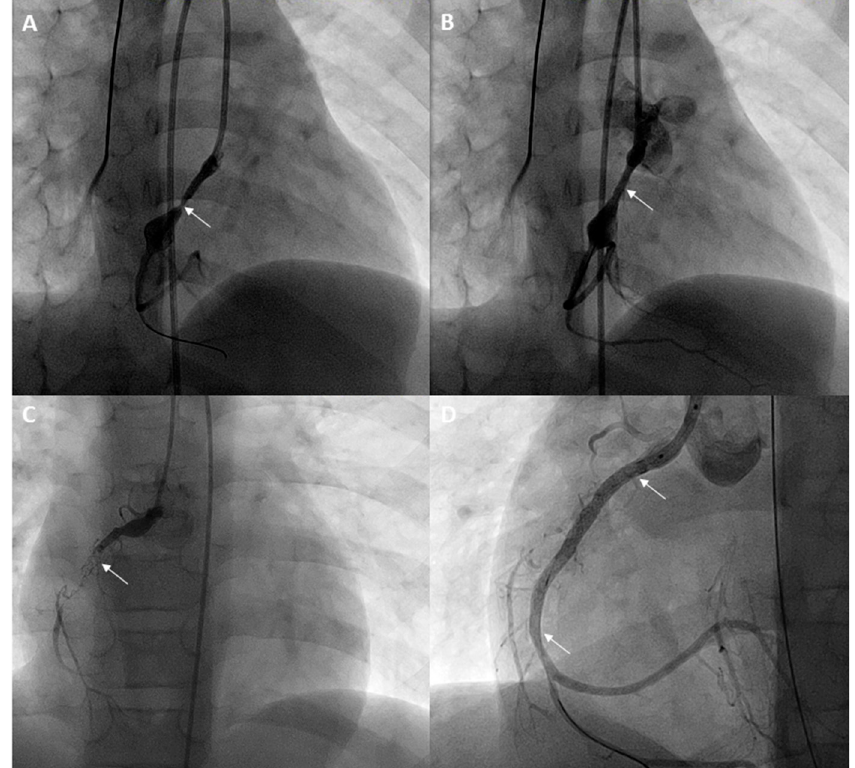
Figure 1. A 7-year-old with a history of Kawasaki disease and giant coronary artery aneurysms of the left main coronary artery and right coronary artery underwent a cardiac catheterization. Fractional flow reserve with adenosine in the right coronary artery (RCA) was 0.74. Stenosis proximal to the aneurysm in the RCA is seen (arrow) ( A ). After placement of a drug-eluting stent, the stenosis has resolved (arrow) ( B ). Two years later, a cardiac MRI showed an inducible perfusion defect in the inferior septum and inferior wall. Angiograms in the RCA showed complete occlusion of the RCA stent (arrow) ( C ). After recanalization and angioplasty, an overlapping stent was placed extending to the distal RCA (lower inferior arrow) ( D ) and an additional proximal stent was also placed (superior arrow) ( D ), reestablishing flow in the RCA.